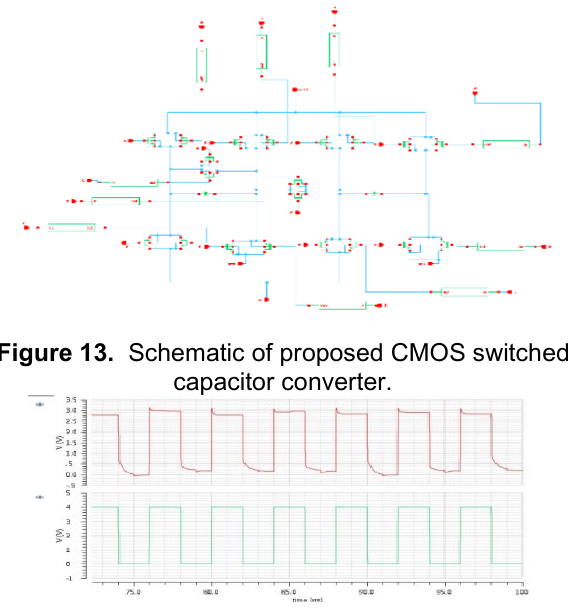
Figure 14. Output waveform of proposed CMOS switched capacitor converter.